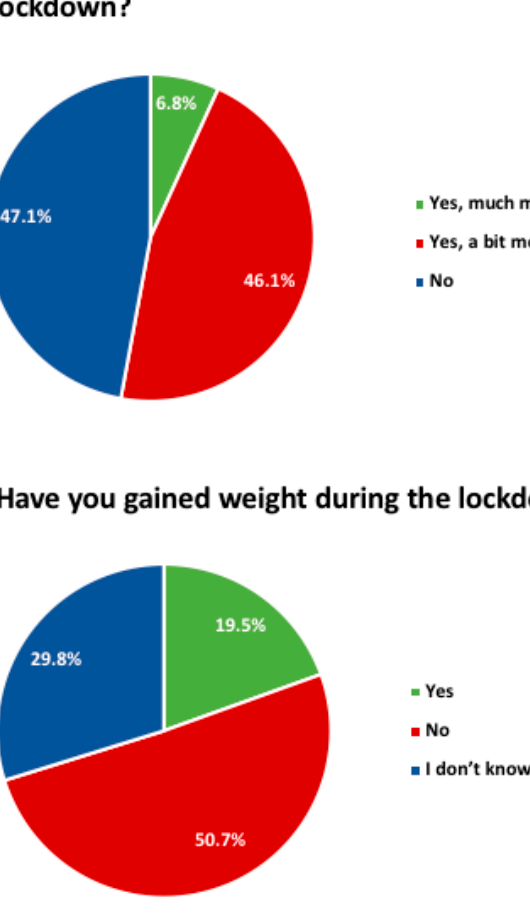
Figure 1. Overall reported dietary changes during the lockdown.